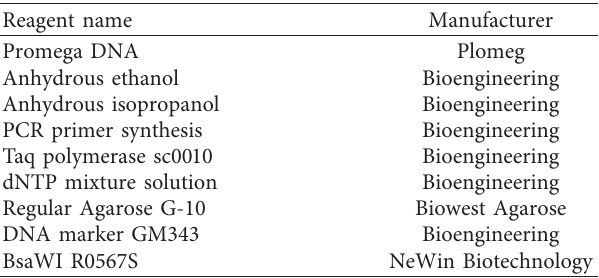
Table 2: List of main